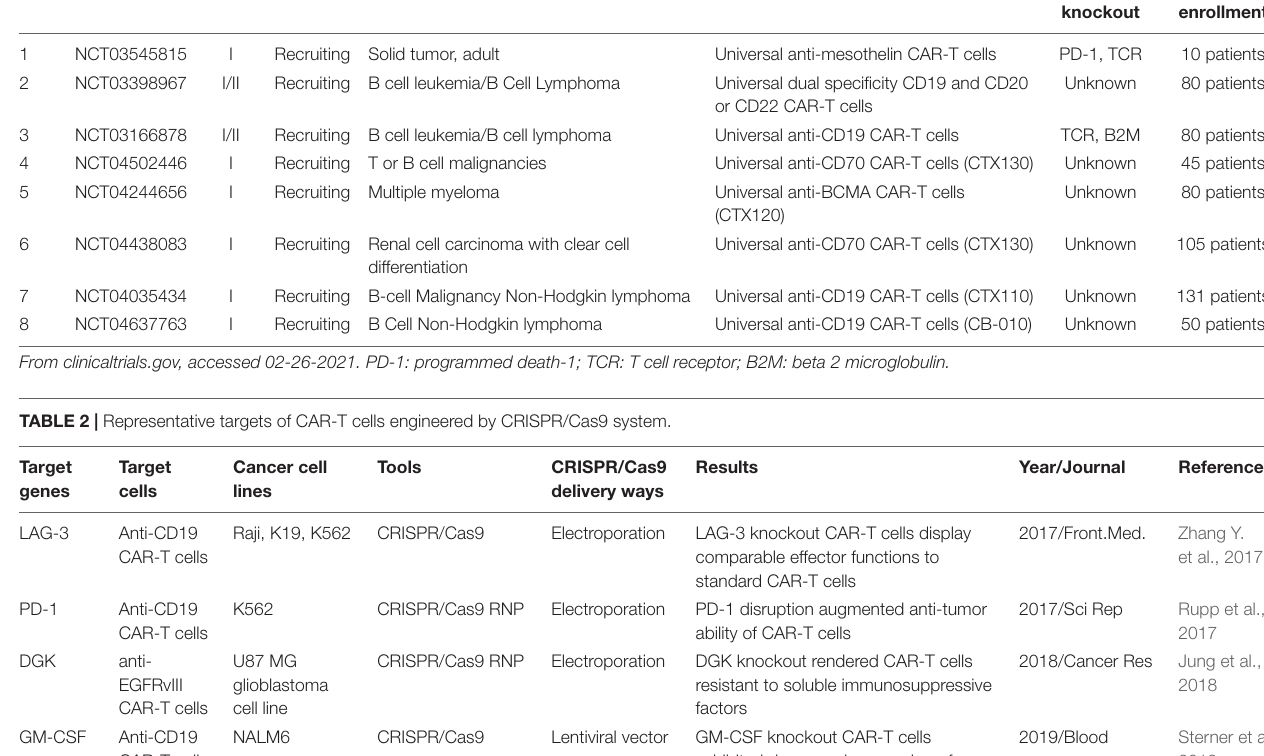
TABLE 1 | Registered clinical trials using CRISPR/Cas9 modified universal CAR-T cells for treatment of malignancies. Row